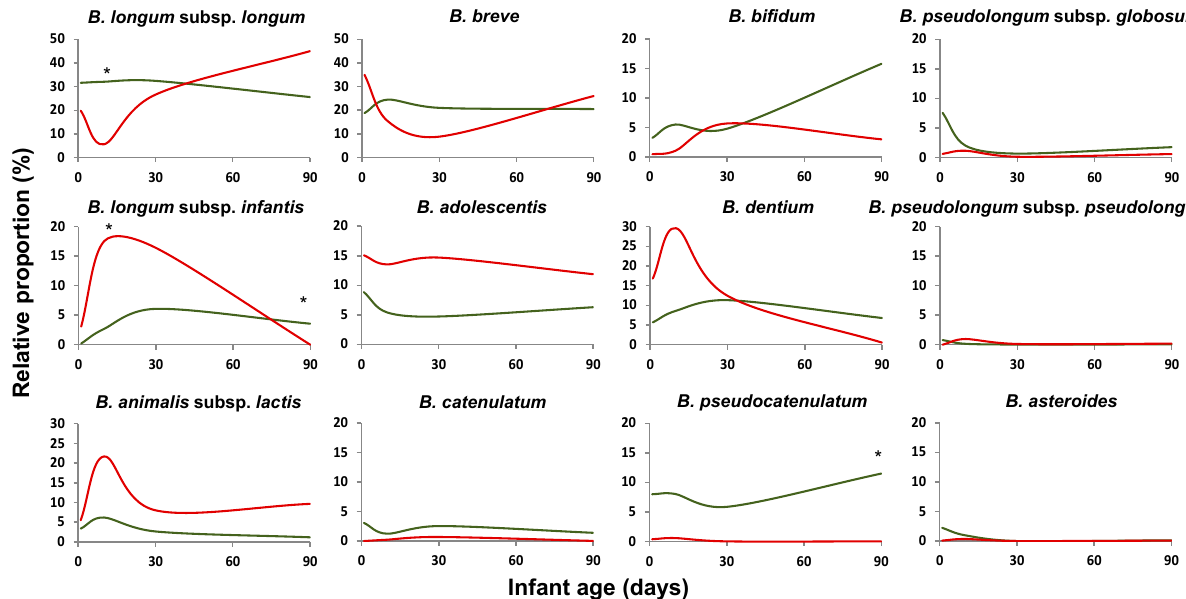
Figure 3. Impact of delivery mode. Average relative proportions, with regard to total bifidobacteria (100%), of the dominant Bifidobacterium species/subspecies (based on ITS-sequencing) during the first three months of life in full-term babies delivered vaginally (green line) or by cesarean section (CS) (red line). * Indicates statistically significant differences ( p < 0.05) at the corresponding sampling time (two, 10, 30, or 90 days of age).